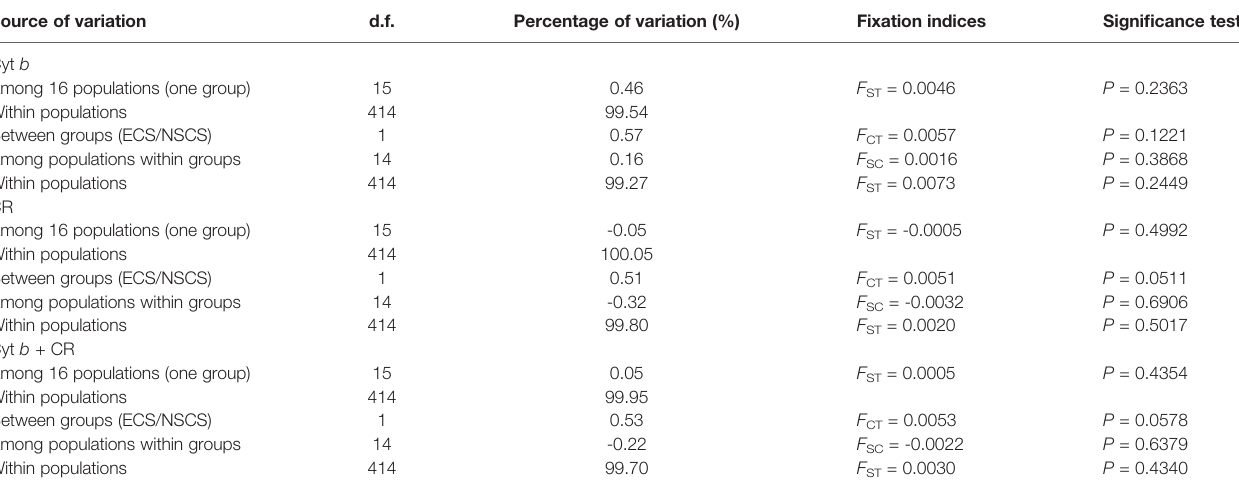
TABLE 3 | Hierarchical analyses of molecular variance (AMOVA) testing genetic subdivision of D. maruads i